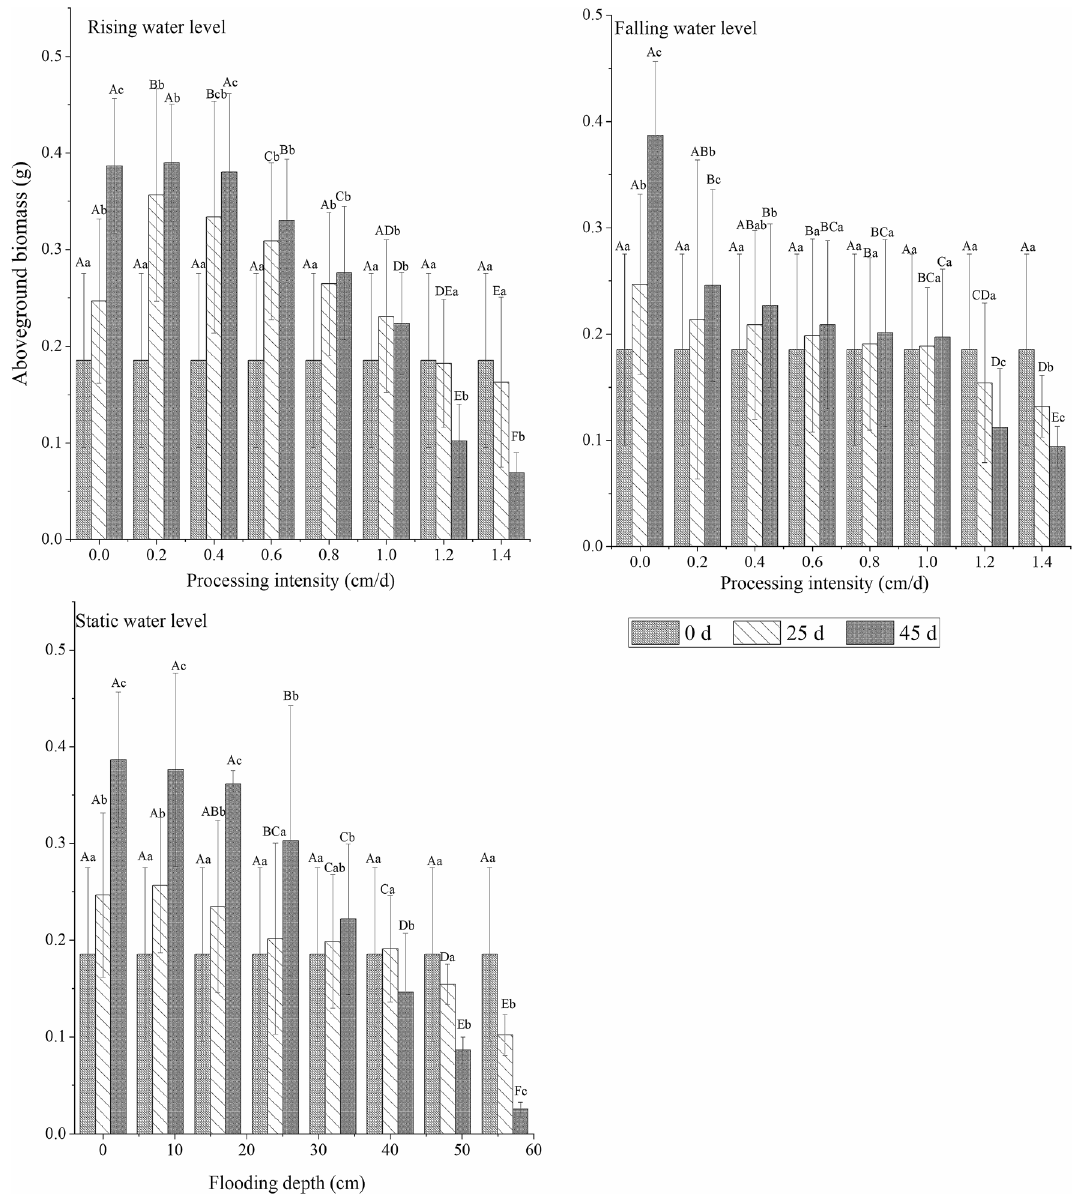
Figure 3. Effects of different hydrological environments on aboveground biomass and bioavailability of C.